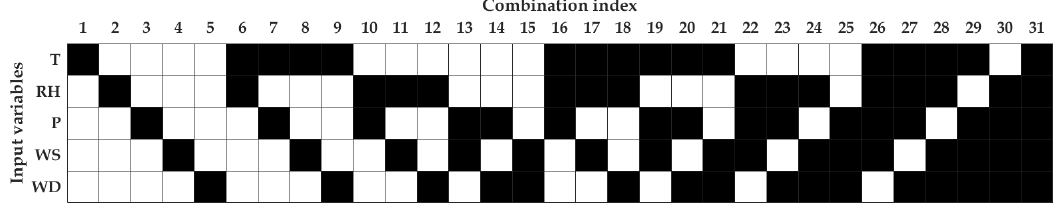
Figure 4. Sensitivity analysis uses different combinations of meteorological variables as inputs for PN